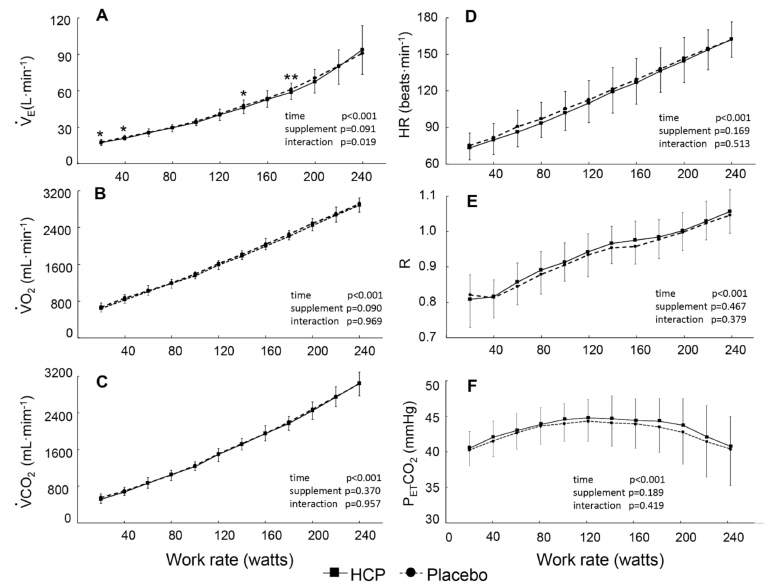
. . V E ) ( A ), O 2 uptake ( VO 2 ) ( B ), CO 2 output